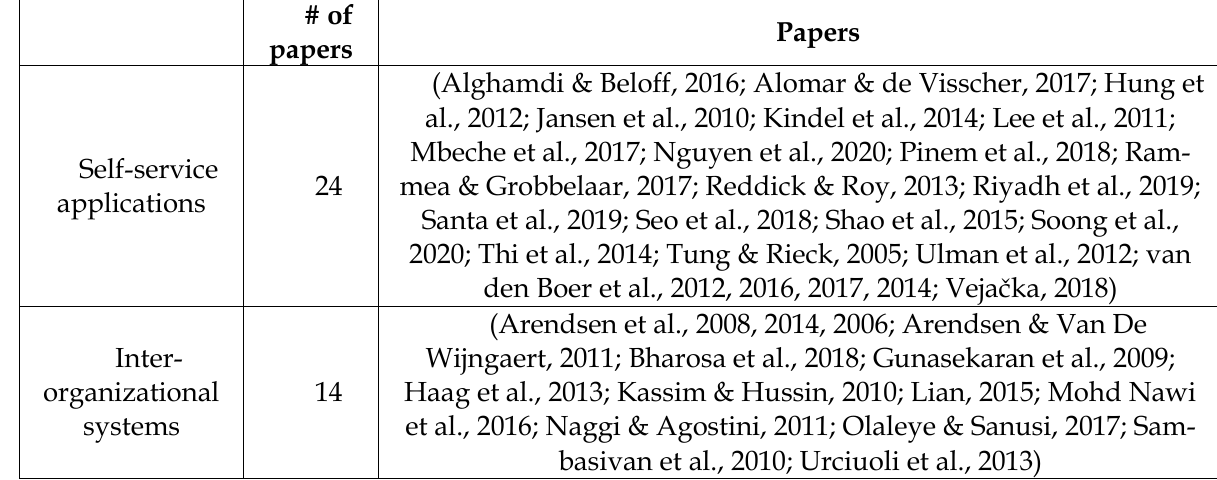
Table 6: Research settings